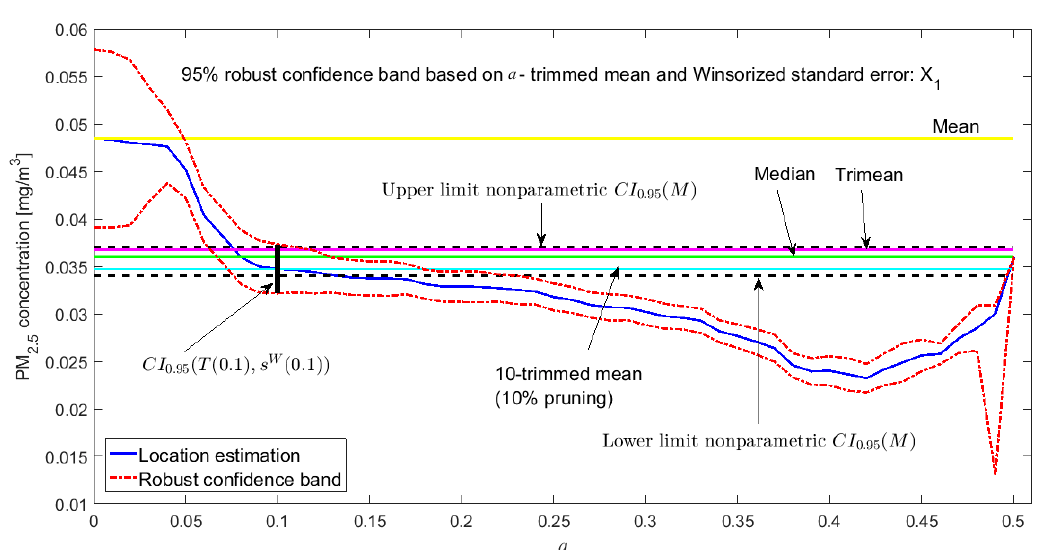
Figure 11. 95% robust confidence band based on the 𝑎 -trimmed mean and Winsorized standard error: 𝑋 (cid:2869) .